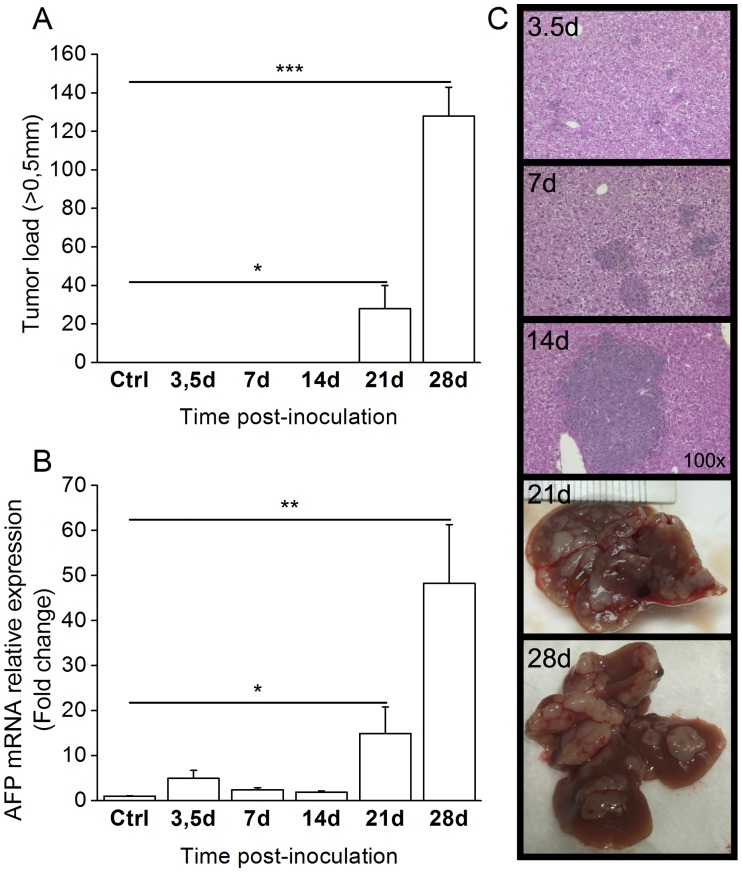
Dt81Hepa1-6 cell transfer leads to rapid tumor development.A suspension of 1M Dt81Hepa1-6 cells was injected intrasplenically in C57BL/6 mice and animals were sacrificed after 3.5 to 28 days. (A) Manual count of tumor >0.5mm. (B) Alpha-fetoprotein (AFP) (Afp) mRNA expression in liver homogenates as measured by qPCR. (C) Representative microphotographs at 100x magnification of HPS-stained liver slices obtained after 3.5, 7 and 14 days. Whole-liver photographs obtained after 21 or 28 days. Control mice were injected with 1M Hepa1-6 cells and sacrificed at each time point (3.5 to 28 days) and pooled for analysis (Ctrl). (*P<0.05; **P<0.01; ***P<0.001).